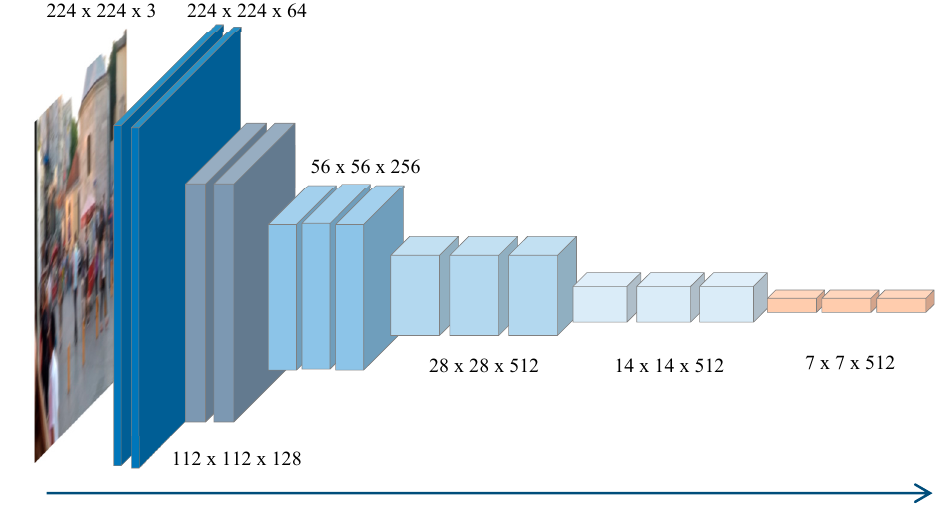
Figure 10. Architecture of VGG16